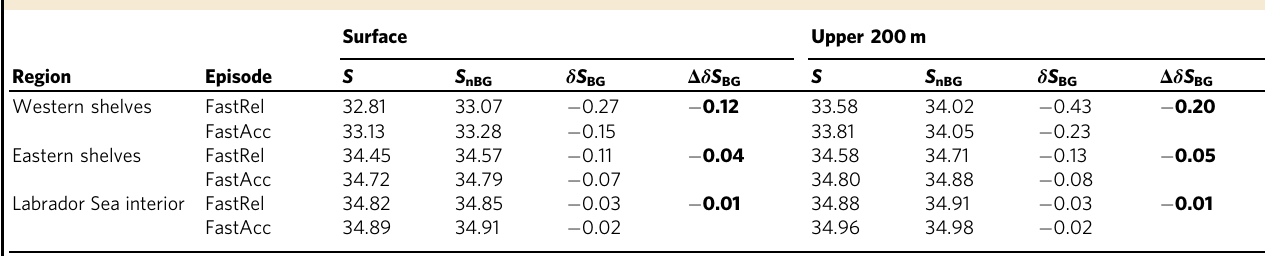
Table 1 Labrador Sea freshening induced by Beaufort Gyre freshwater.